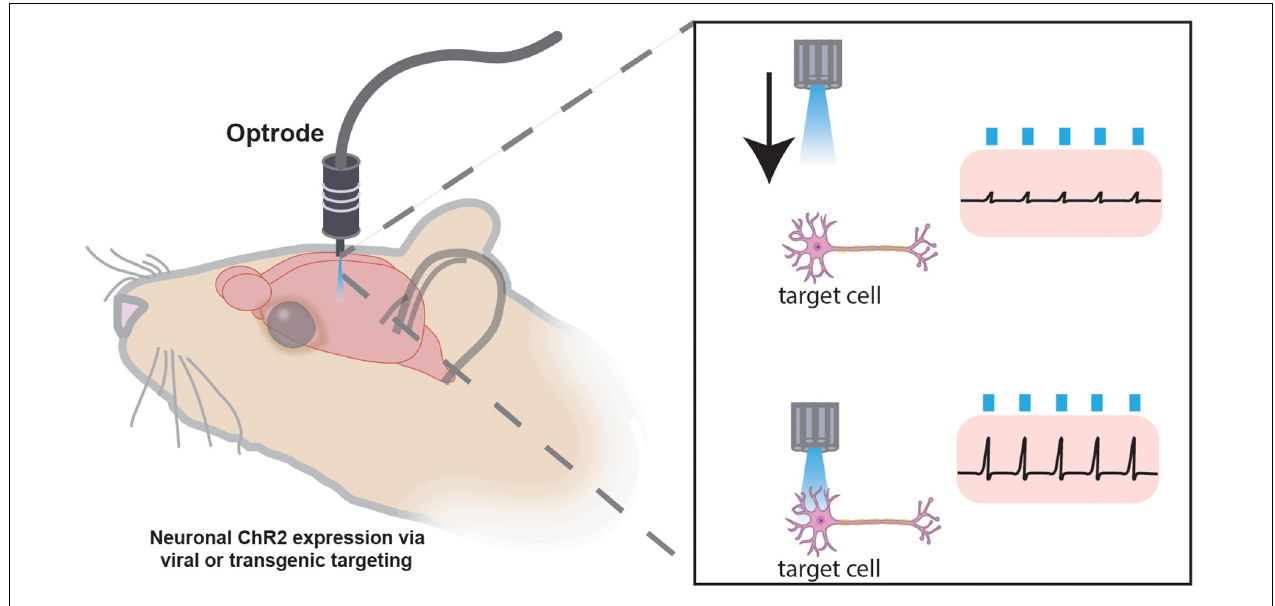
FIGURE 7 | Optogenetic “sonar” method for targeting specific cellular populations for in vivo electrophysiology. Photostimulation “sonar” guides optrode to genetically targeted neurons expressing channelrhodopsin (ChR2) for extracellular electrophysiology recordings. Once the electrode is juxtaposed to a ChR2-expressing cell of interest, electrophysiological recordings may be performed. The optrode may have one or many channels for recording numerous cells simultaneously.